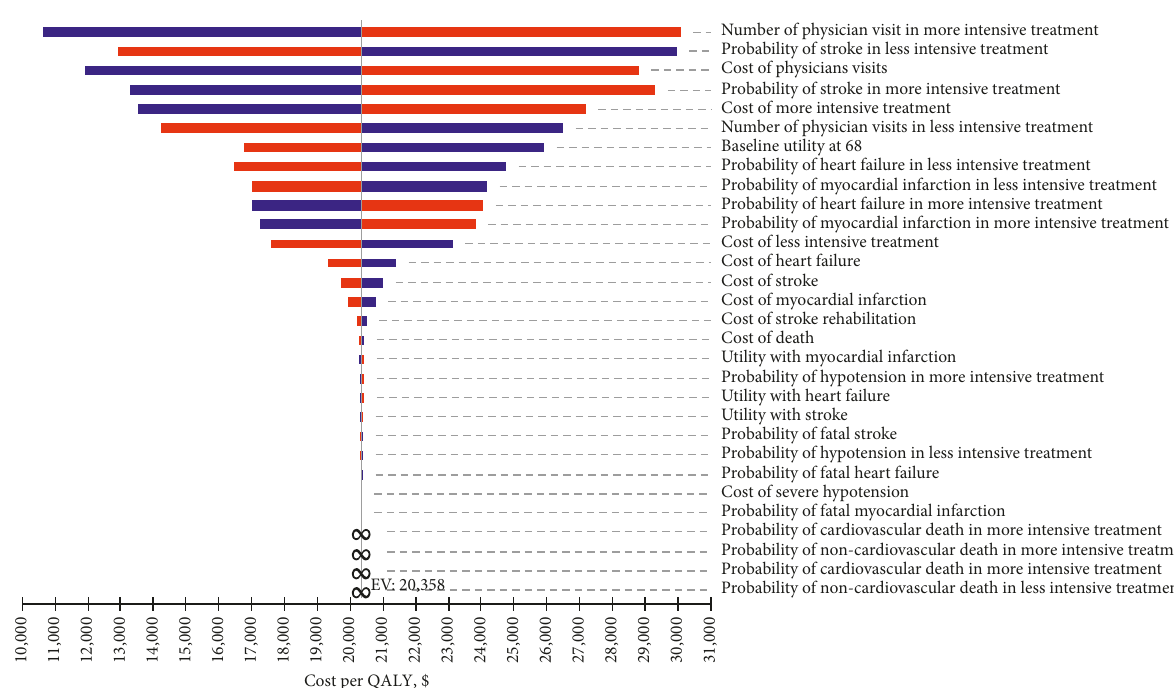
Figure 2: Tornado diagram of multiple one-way sensitivity